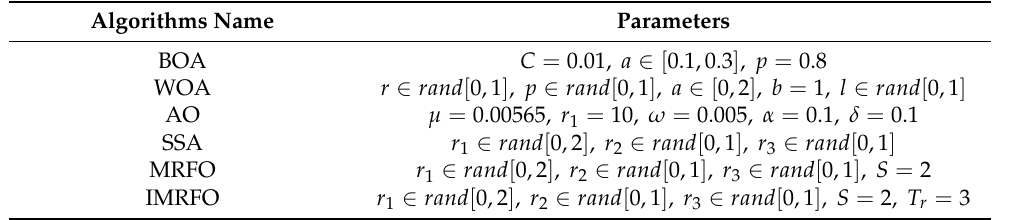
Table 6. Parameter settings of each